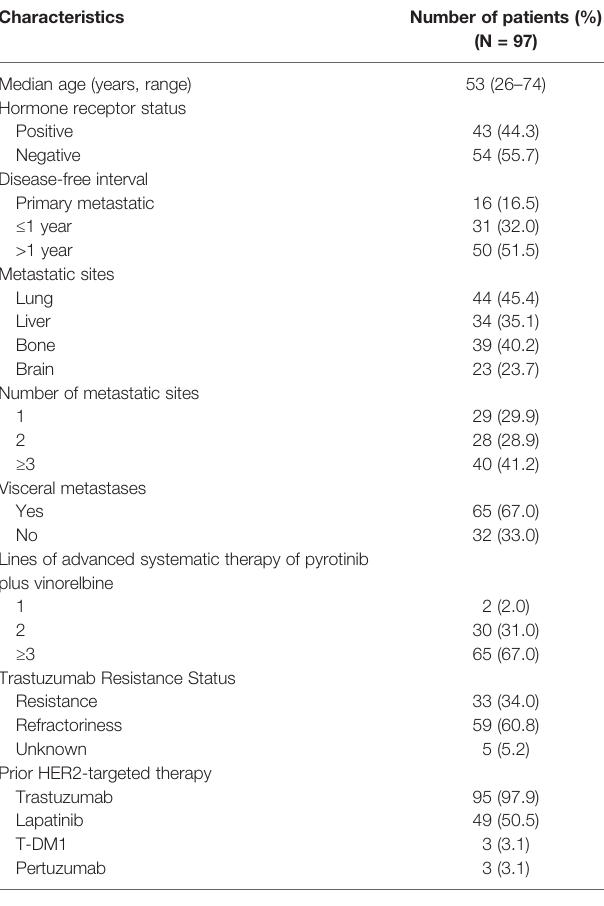
TABLE 1 | Patient characteristics at baseline.